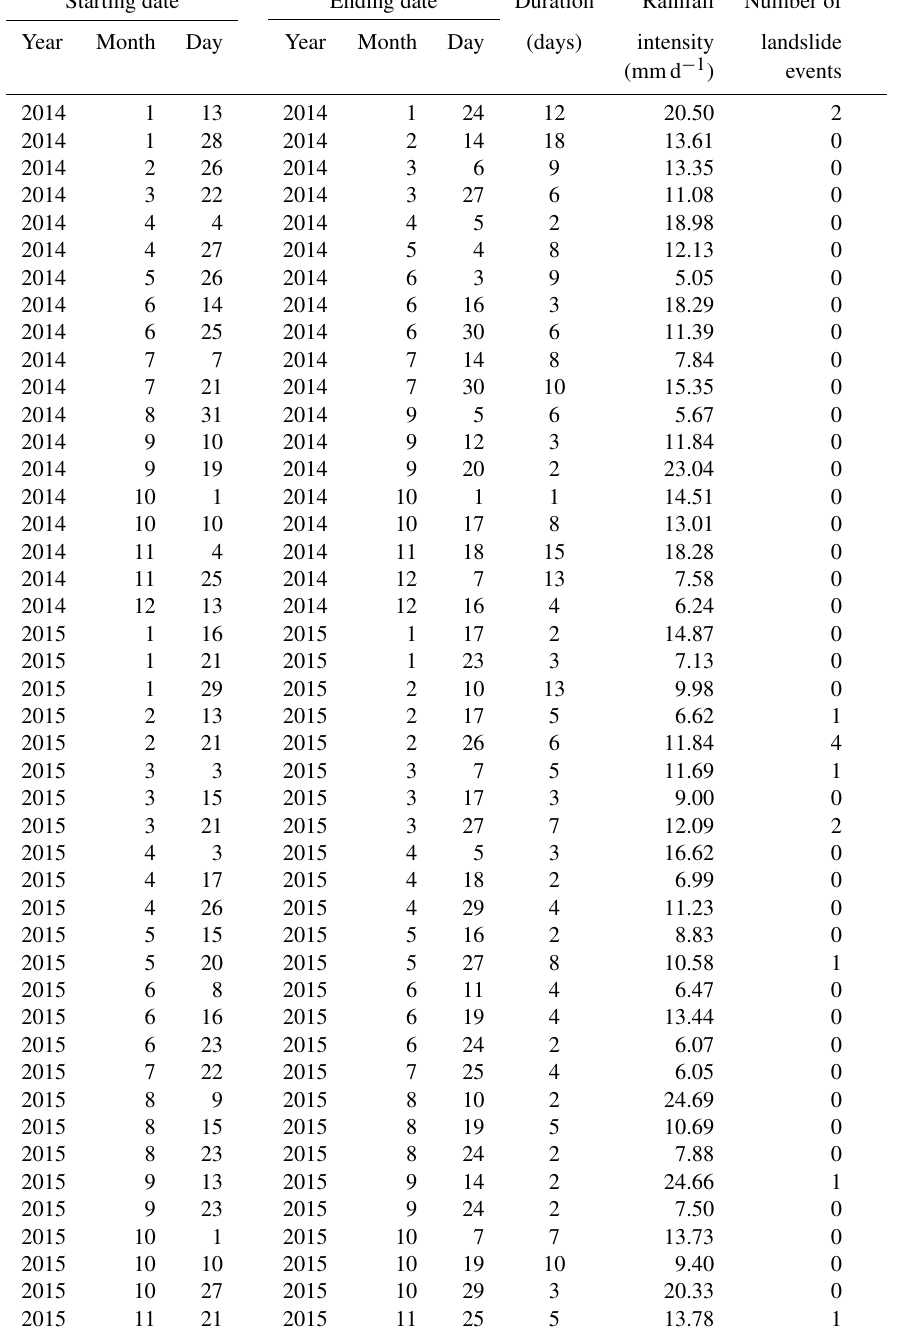
Table 5. Rainfall events